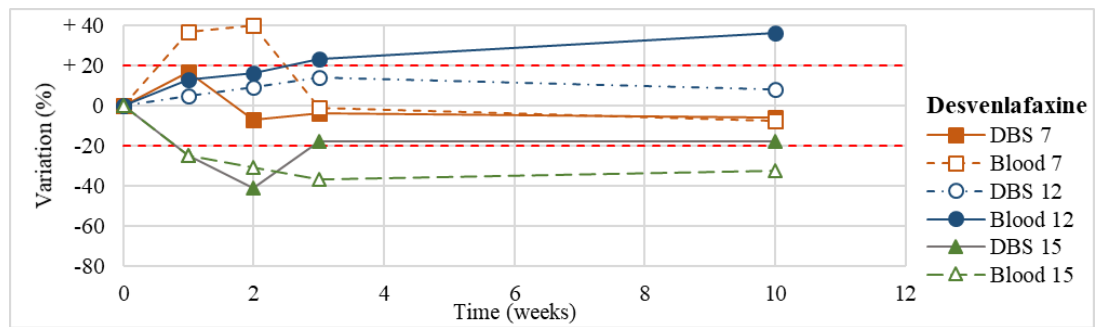
Figure 7. Long-term stability of desvenlafaxine ( n = 3) in DBSs stored at room temperature and in blood stored at −20 °C.